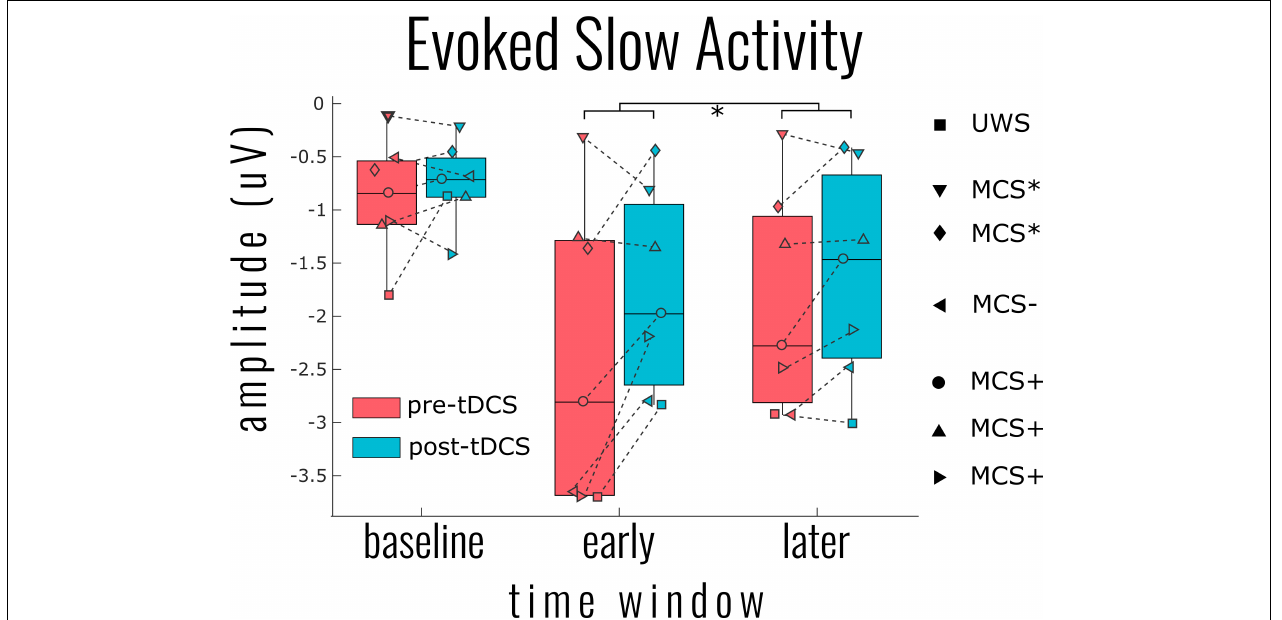
FIGURE 2 | Group results for the effect of transcranial magnetic stimulation (tDCS) on the evoked slow activity. The single point per individual indicates the most negative 5% of activity across all channels within the indicated time windows: baseline ( − 400 to − 100 ms), early (0–200 ms), and later (200–400 ms). This percentile approach within time windows was necessary to generalize the patterns of results over all patients given the highly individualized responses. Linear mixed model analysis indicated a significant reduction of slow activity (i.e., smaller negative amplitude) at both the early and later time windows [ χ 2 (2) = 12.141, p = 0.002]. A significant tDCS effect was found for all negative percentiles across channels from 5% (shown) to 50%.